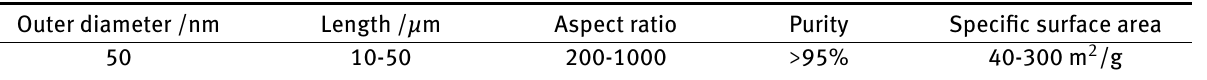
Table 3: Physical properties of MWCNTs